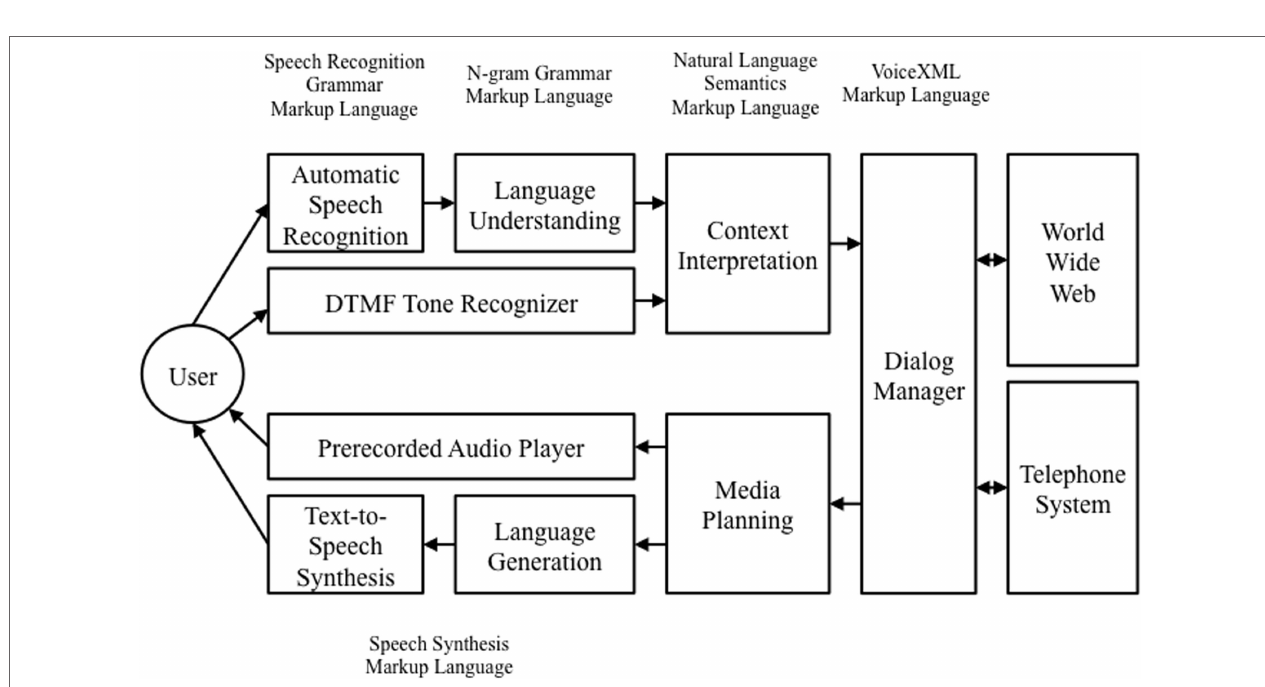
FIGURE 2 | Structure of the W3C ‘standard’ Speech Interface Framework (W3C-SIF, 2000).